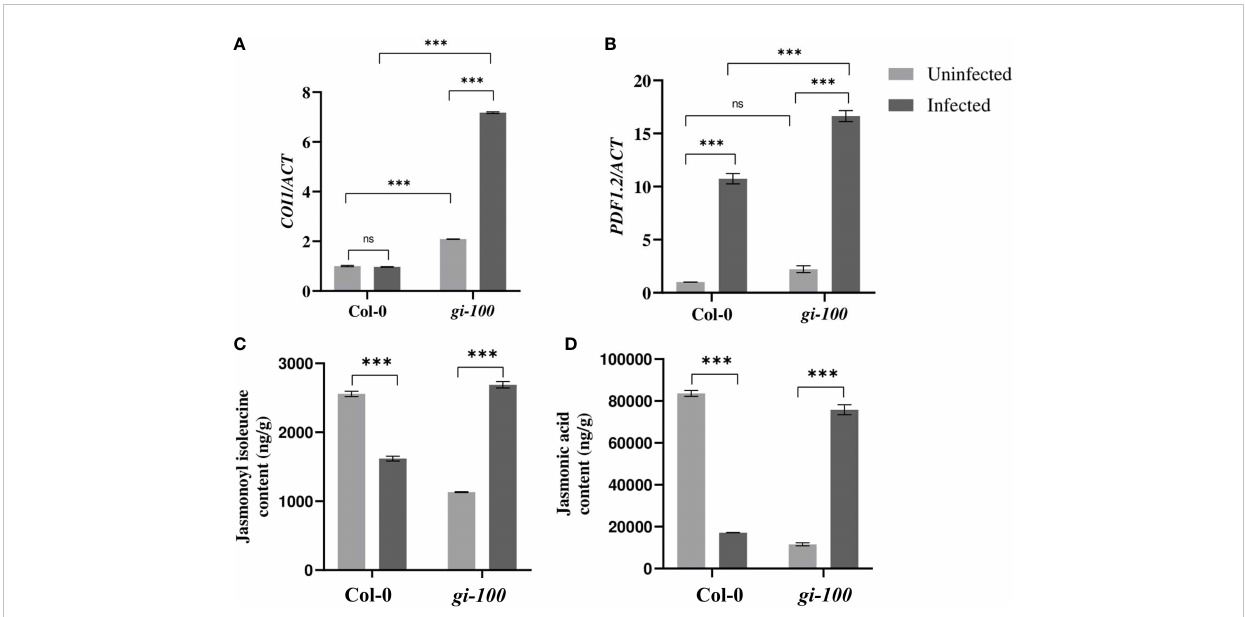
FIGURE 5 Involvement of the jasmonic acid pathway during F. oxysporum infection in gi-100 plants. (A, B) Transcript expression validation using RT-qPCR and (C, D) quantitative pro fi ling of jasmonic acid and jasmonyl-(L)-isoleucine amount at 24 DPI by F. oxysporum were done in gi-100 and Col-0 leaf samples. (A, B) Relative transcript levels of (A) CORONATINE INSENSITIVE 1 ( COI1 ) and (B) PLANT DEFENSIN1.2 ( PDF1.2 ). ACTIN was used to normalize transcript levels. Determination of (C) jasmonic acid hormone and (D) jasmonyl-(L)-isoleucine JA-ile amounts. For JA and JA-ile quanti fi cation, D6-jasmonic acid and jasmonic acid-[13C6] isoleucine conjugate were taken as standard. The qRT-PCR reactions were done in triplicate from three biological replicates.Values are expressed as mean ± SD. Two-way analysis of variance (ANOVA) using Sidak ’ s multiple comparisons test was performed with the help of GraphPad Prism to test for signi fi cance among the dataset, *** p < 0.001. ns, Non-signi fi